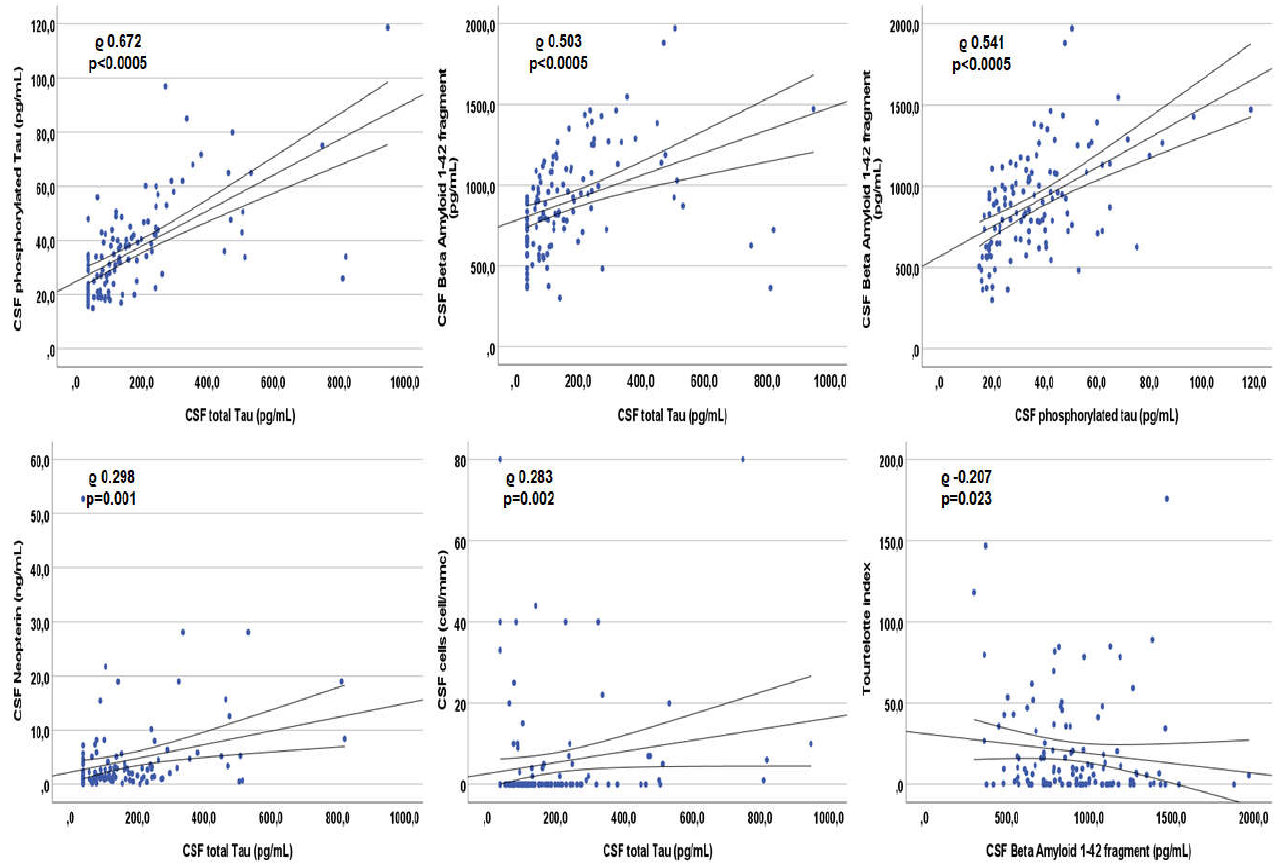
Figure 5. Spearman’s correlations between each other Alzheimer’s dementia biomarker and other markers within the cerebrospinal fluid of patients with detectable plasma viremia.